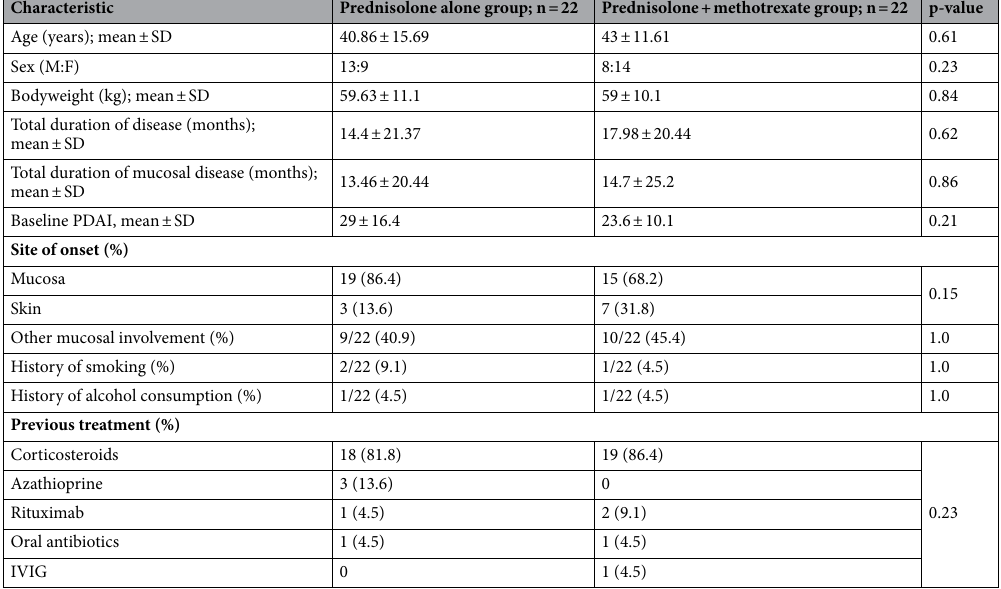
Table 1. Comparison of baseline clinicodemographic characteristics of the groups.